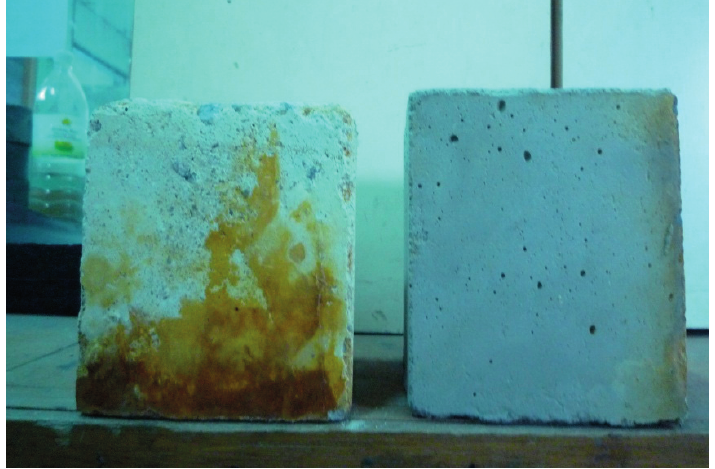
Figure 14. Change in colour and corner losses for SCHSC with and without treated